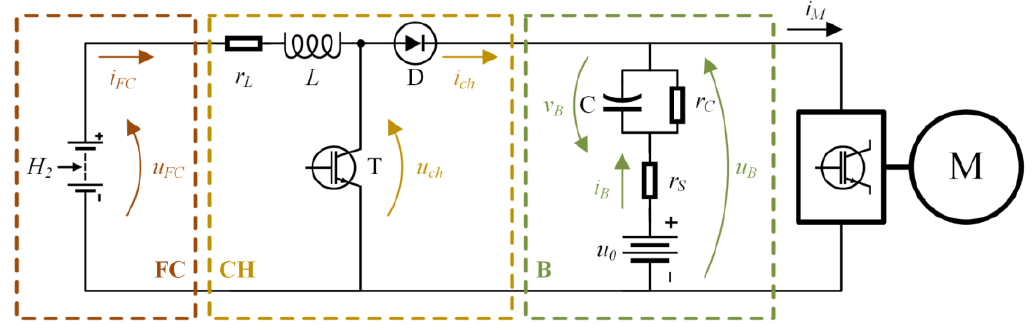
Figure 1. The FCBEV electric propulsion system: fuel cell (FC), boost converter (CH), battery (B), and traction motor (M).